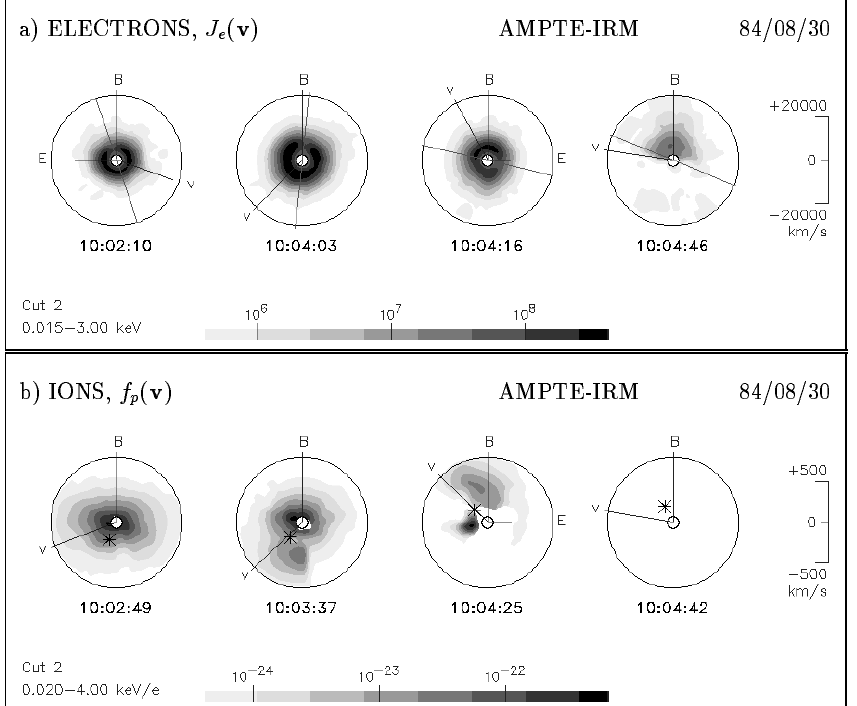
Fig. 7. Ion distributions in the energy range of 20eV–4keV and electron dis- tributions in the range of 15eV–3keV measured on 17 September 1984. The format is the same as in Fig.